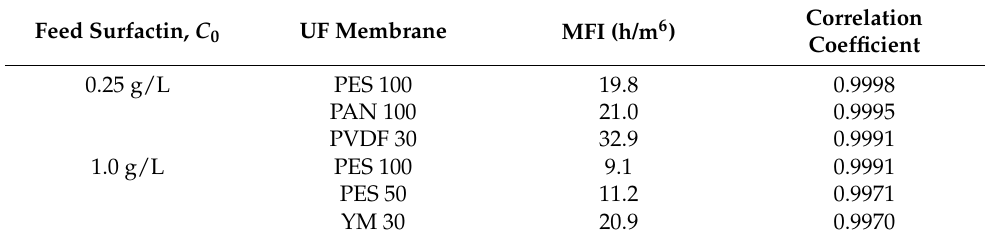
Table 2. MFI values determined using various UF membranes.